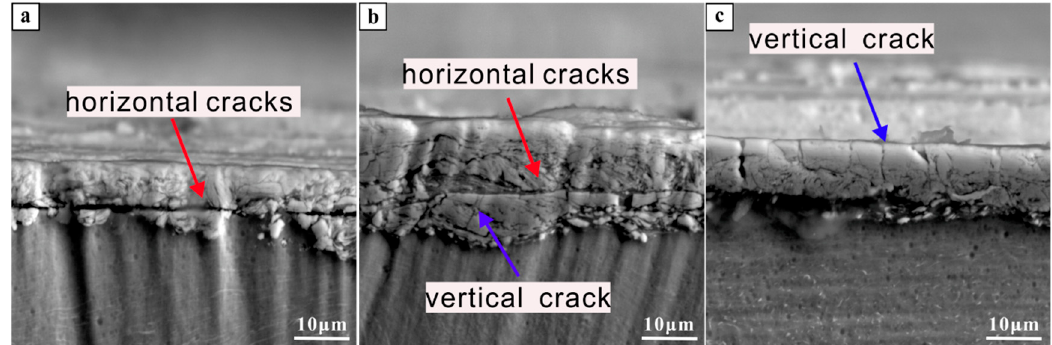
Figure 8. Cross-section comparison of Ti-6Al-4V alloy produced by ( a ) forging, ( b ) SLM and ( c ) EBM.